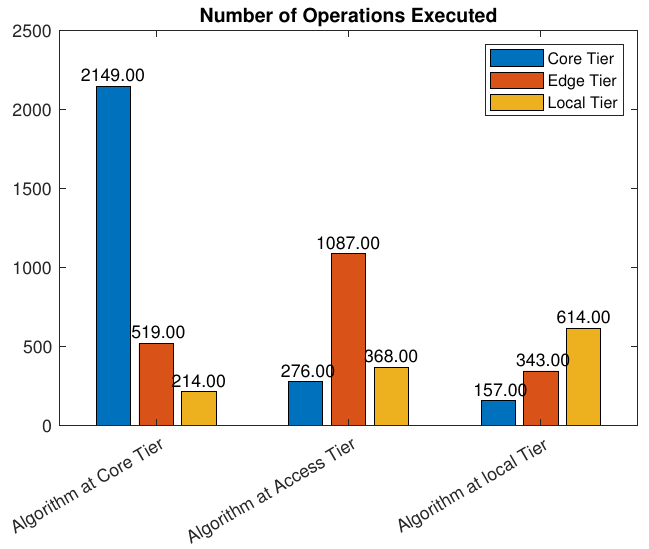
Figure 12. Number of operations executed: without the